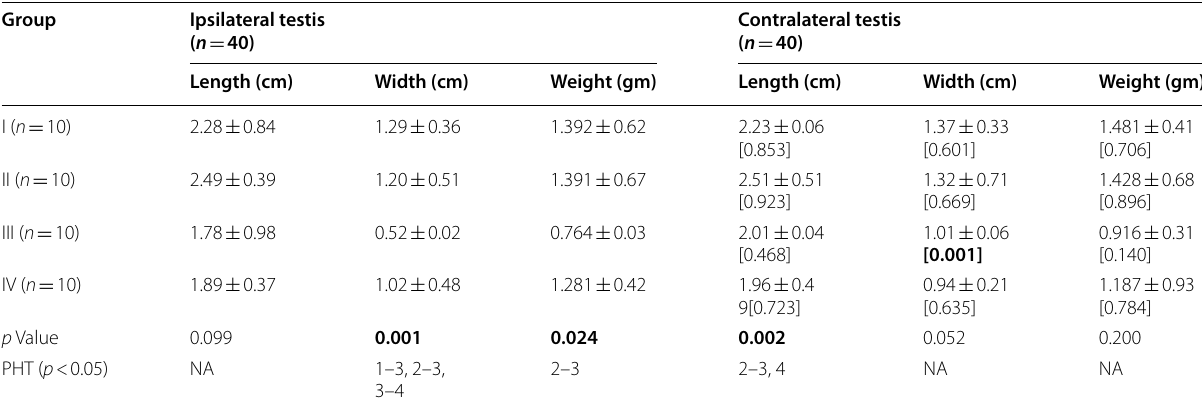
Table 2 Mean testicular size and weight at 120 days of life ( n